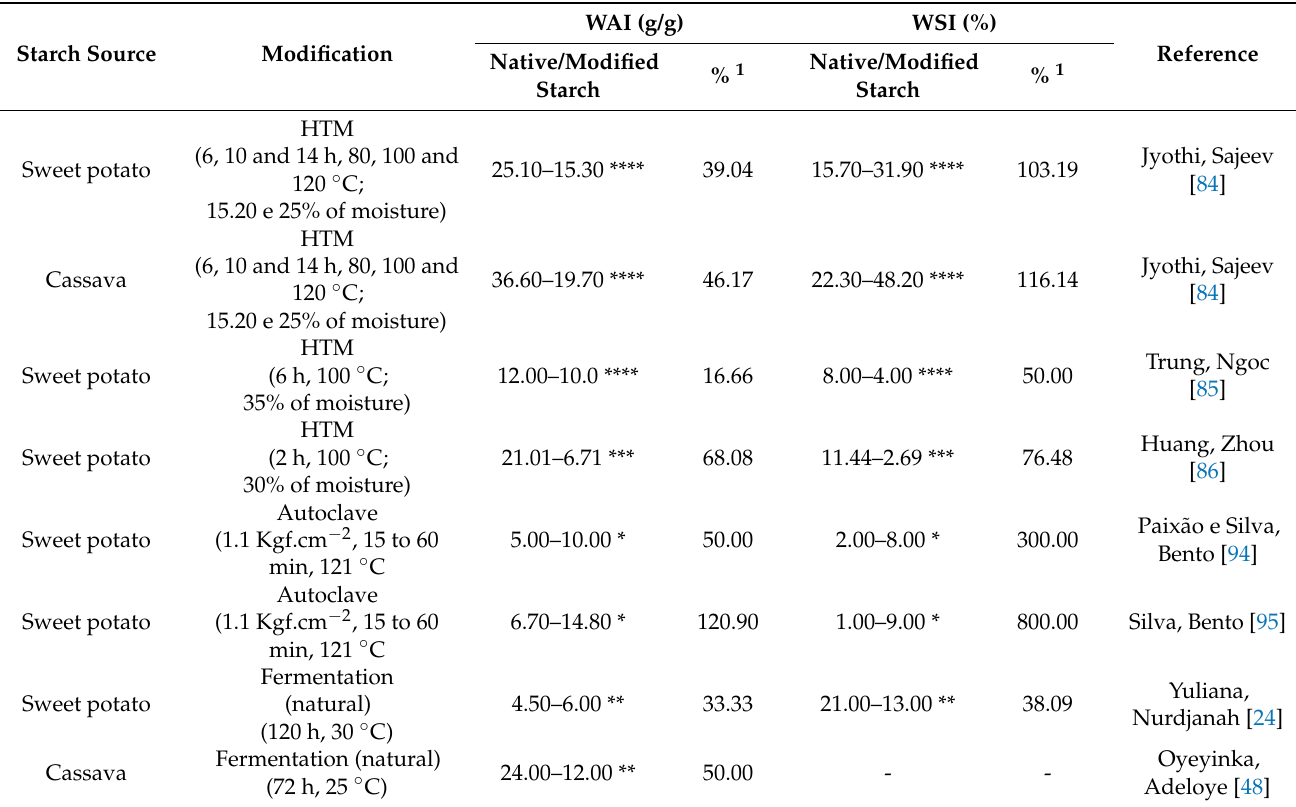
Table 2. Water absorption index (WAI) and water solubility index (WSI) of native and modified starches by heat moisture treatment (HTM), autoclave, and